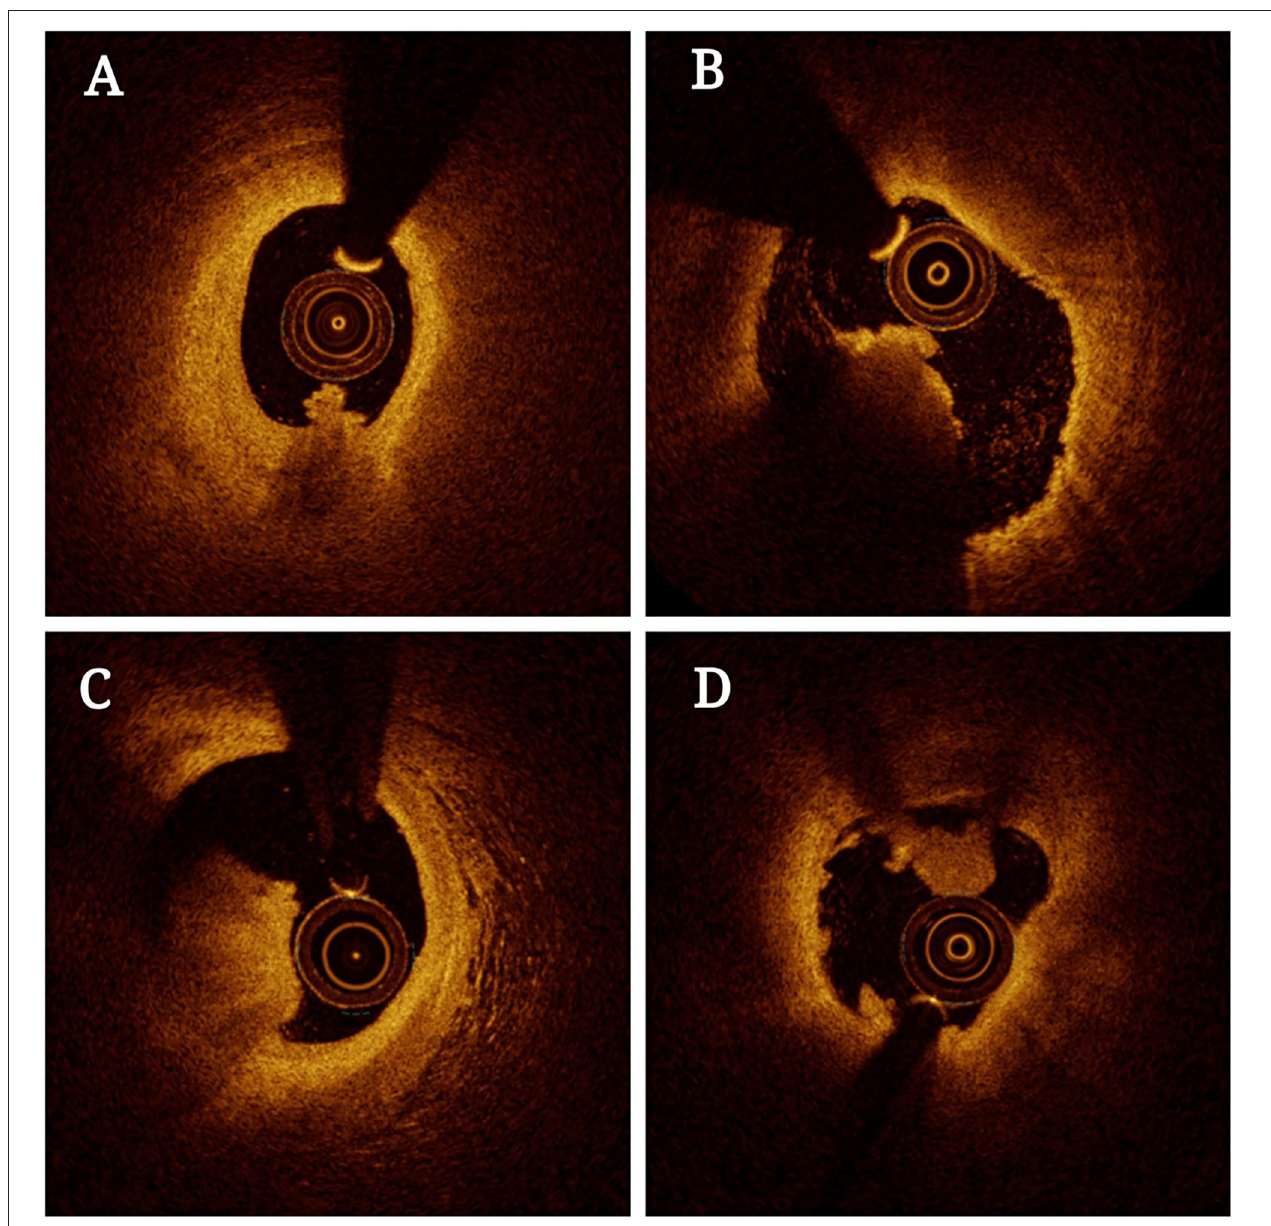
FIGURE 2 | Optical coherence tomography (OCT) of thrombosis in atherosclerosis patients. The presence of residual red thrombus limits the visualization of plaque morphology (A–C) . OCT images in the distal and proximal segments of the thrombotic lesions exhibit an absence of superficial lipids or calcification (B,D) .